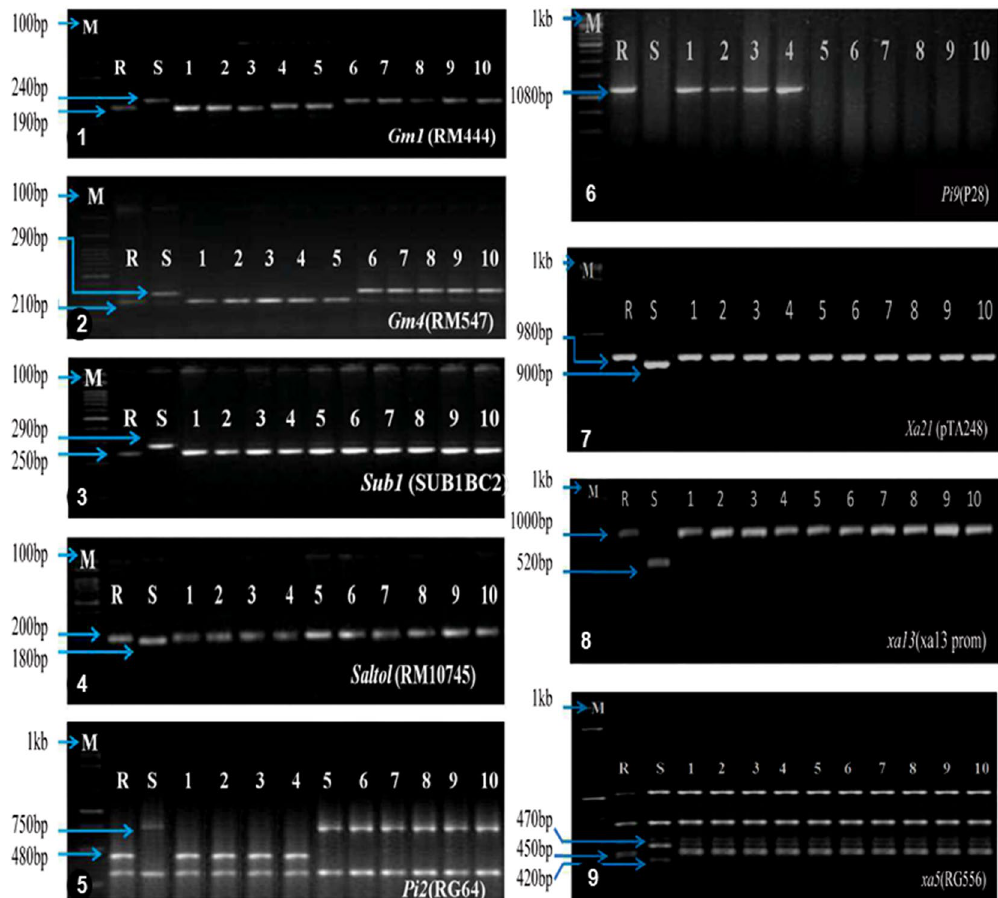
Figure 3. PCR analysis of gene pyramids for the presence target allele(s) (cropped gels displayed). 1. DNA amplification of Gm1 alleles using the primer RM444. 2. DNA amplification of Gm4 alleles using the primer RM547. 3. DNA amplification of Sub1 allele using the primer SUB1BC2. 4. DNA amplification of Saltol alleles using the primer RM10745. 5. DNA amplification of Pi2 alleles using the primer RG64 and digested with HaeIII . 6. DNA amplification of Pi9 alleles using the primer P28. 7. DNA amplification of Xa21 alleles using the primer pTA248. 8. DNA amplification of xa13 alleles using the primer xa13Prom. 9. DNA amplification of xa5 alleles using the primer RG556 and digested with DraI . M = Marker. For Gm1 , Gm4 , Sub1 and Saltol the M.W. marker was100 bp ladder and for Pi2 , Pi9 , Xa21 , xa13 and xa5 the M.W. marker was 1 kb ladder. S = Recurrent parent (susceptible) R = Resistant (donor) parent. The numbers (1–10) represent different gene pyramids. 1 = ITGP1, 2 = ITGP2, 3 = ITGP4, 4 = ITGP5, 5 = ITGP7, 6 = ITGP9, 7 = ITGP10, 8 = ITGP14, 9 = ITGP18, 10 = ITGP20.